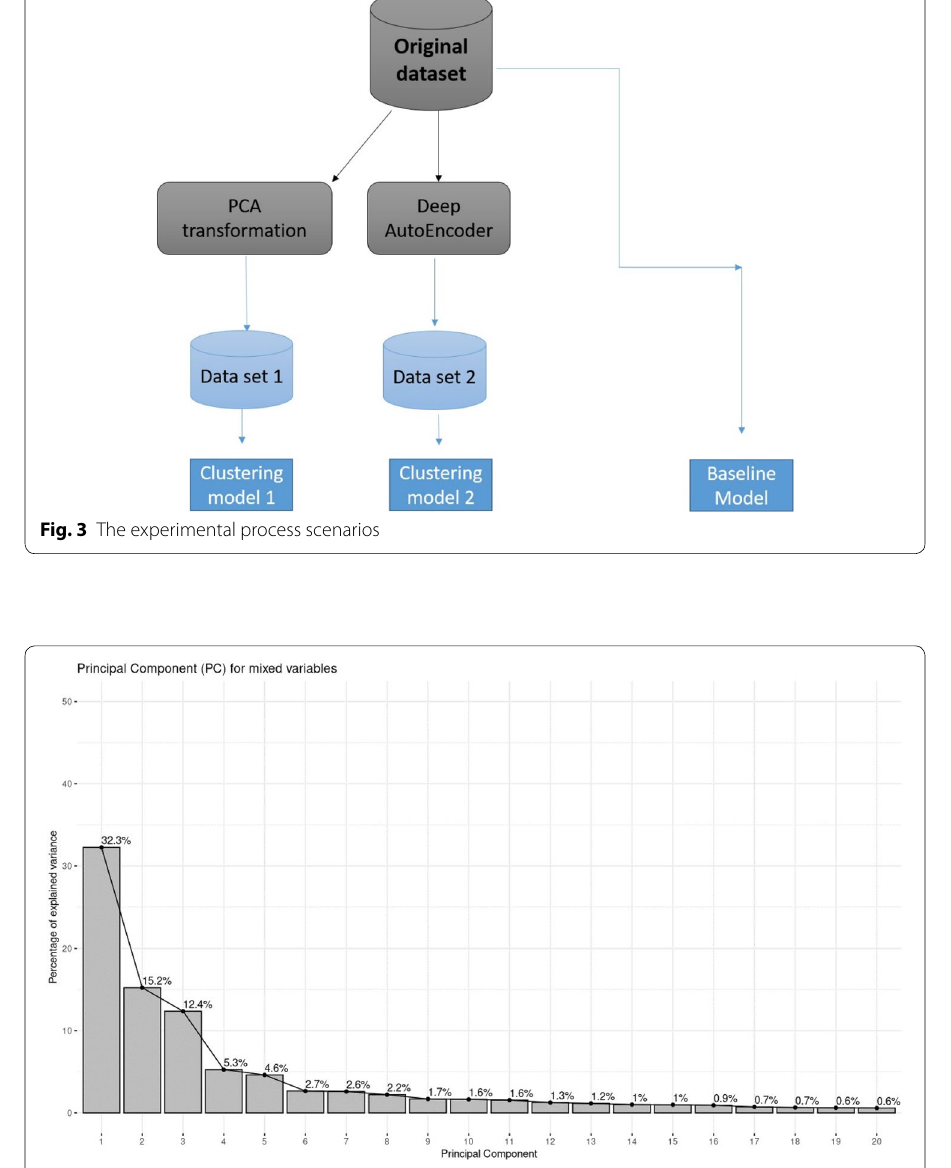
Fig. 4 Scree plot for the first 20 principal